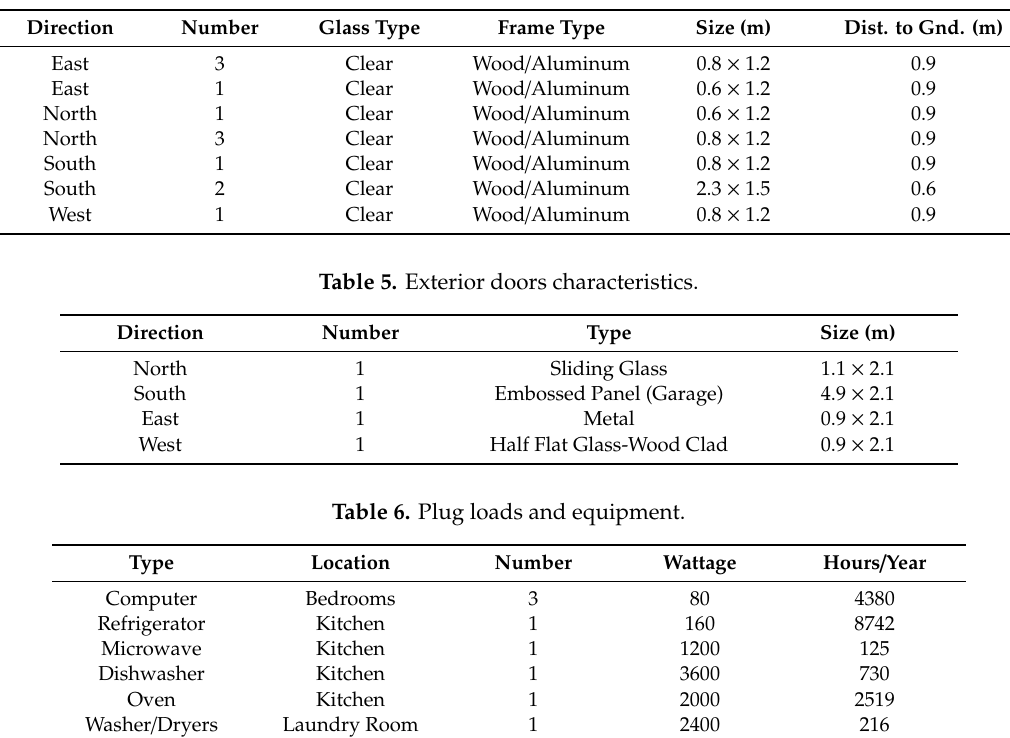
Table 4. Window characteristics.